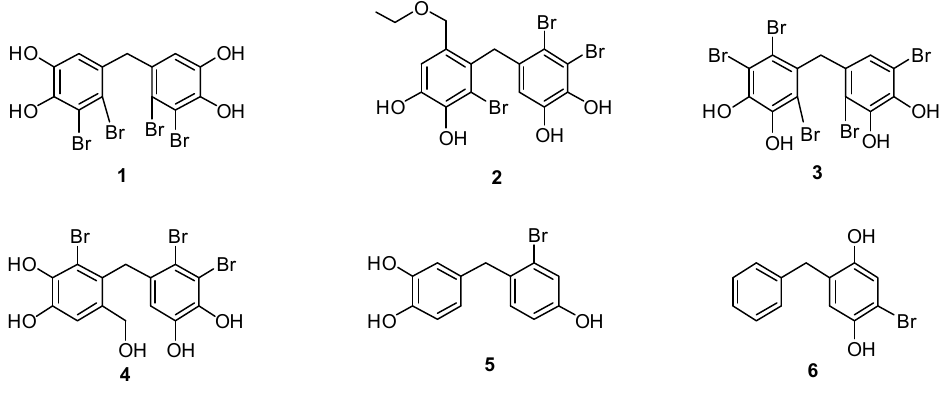
Figure 1. Some important natural and synthetic